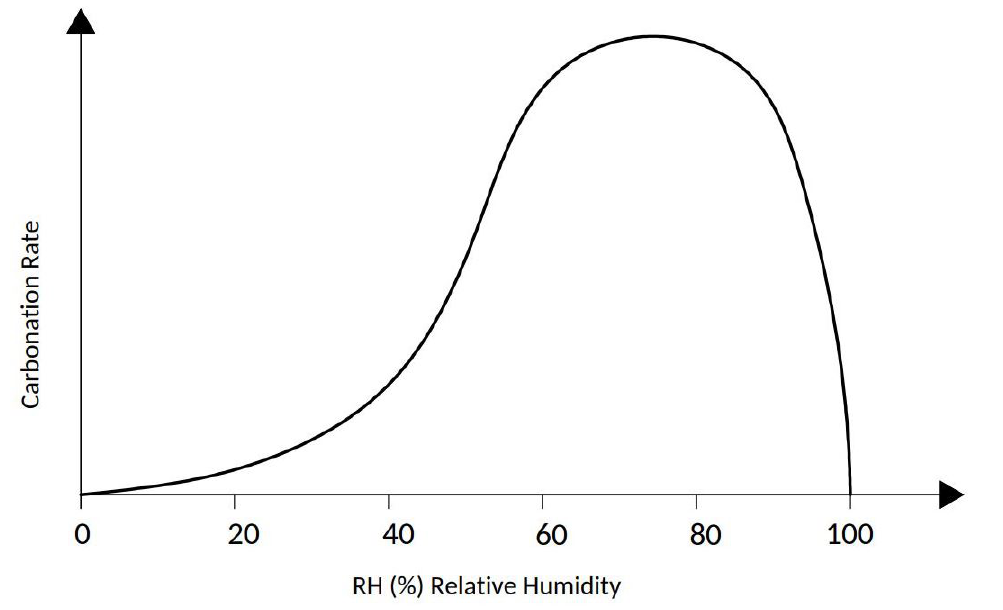
Figure 4. Schematic representation of the carbonation rate of concrete as a function of the relative humidity of the medium, under equilibrium conditions